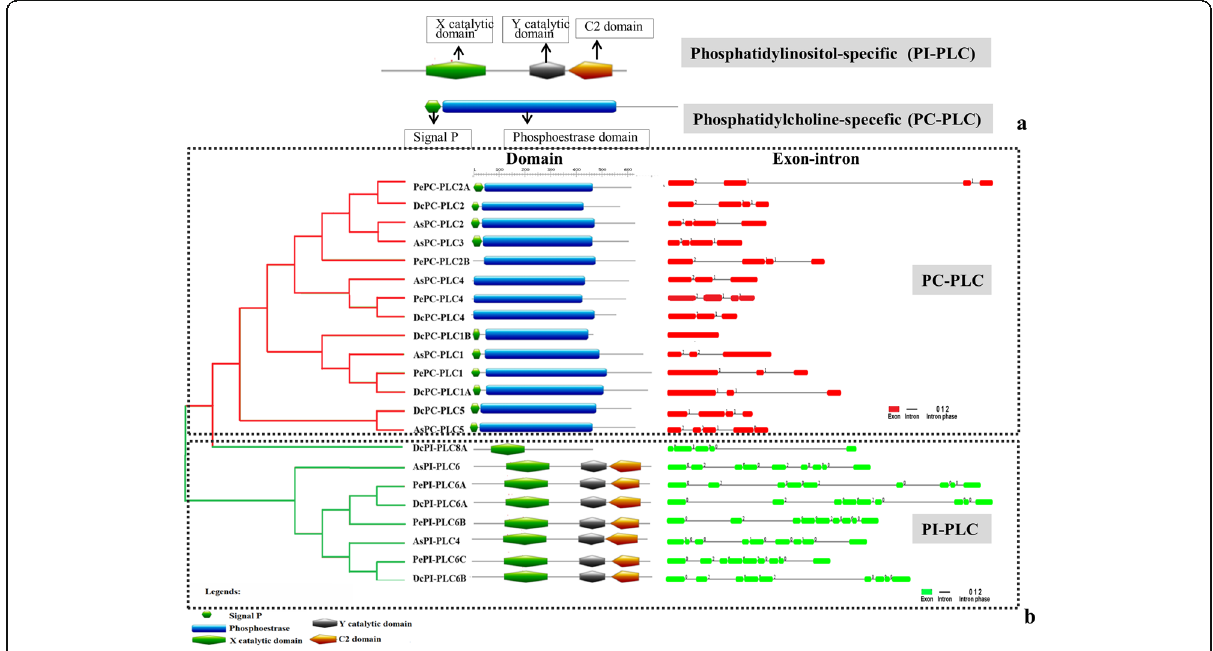
Fig. 1 Domain and gene architecture analysis. a Specific domains of PI-PLC (X catalytic domain, Y catalytic domain, calcium/lipid-binding) and PC-PLC (signal P and phosphoesterase) categories. b Domains and exon-intron architecture for PI-PLC and PC-PLC for P. equestris , D. catenatum , and A.